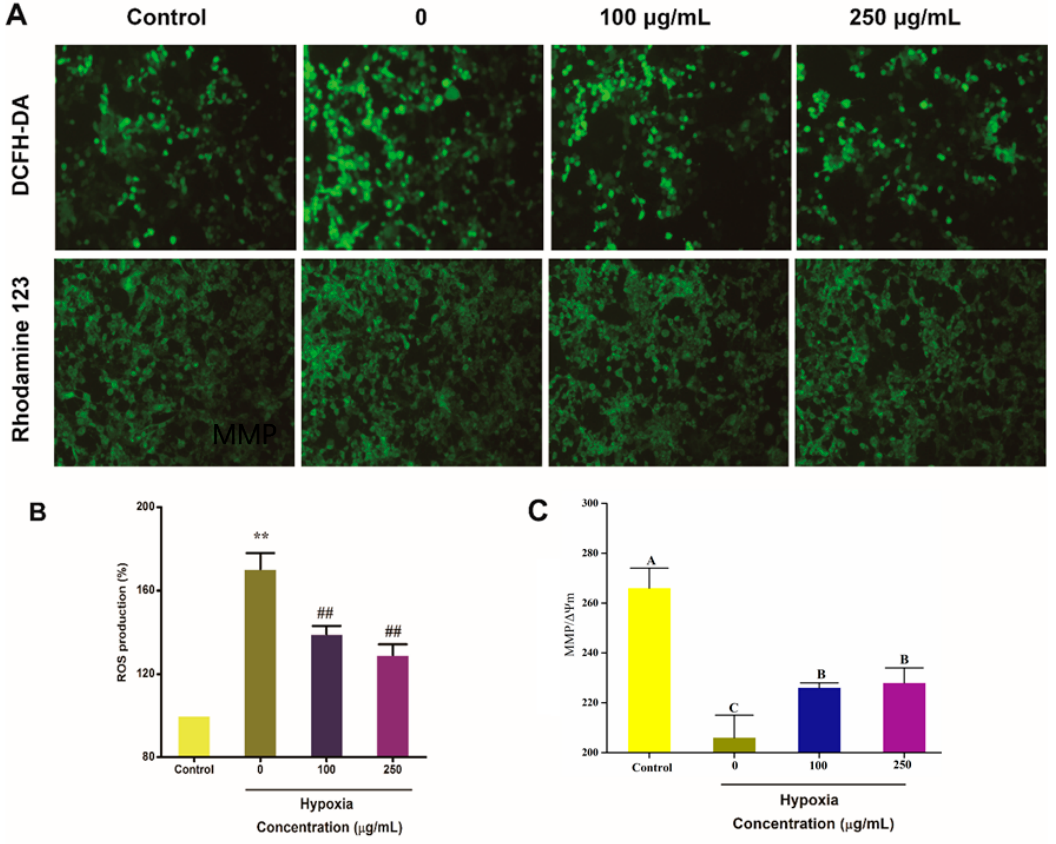
Figure 4. IPA protects hypoxia-damaged PC12 cells from overproduced ROS and mitochondrial damage. ( A ) Representative images showing the e ff ects of IPA on reducing the overproduced ROS by DCFH-DA staining and the mitochondrial membrane potential ( ∆Ψ m) in hypoxia-damaged PC12 cells as determined by Rhodamine-123 (original magnification, × 100). ( B ) The ROS production for each PC12 cell treatment. ( C ) The ∆Ψ m for each PC12 cell treatment. Data are expressed as the mean ± SD (n = 3; one-way analysis of variance followed by the T -test). The di ff erent uppercase letters A, B, C indicate significant di ff erences, all experiments were conducted in triplicate. ** p < 0.01 indicates a significant di ff erence versus the control group. ## p < 0.01 indicates a significant di ff erence versus the 0 group under hypoxia condition.